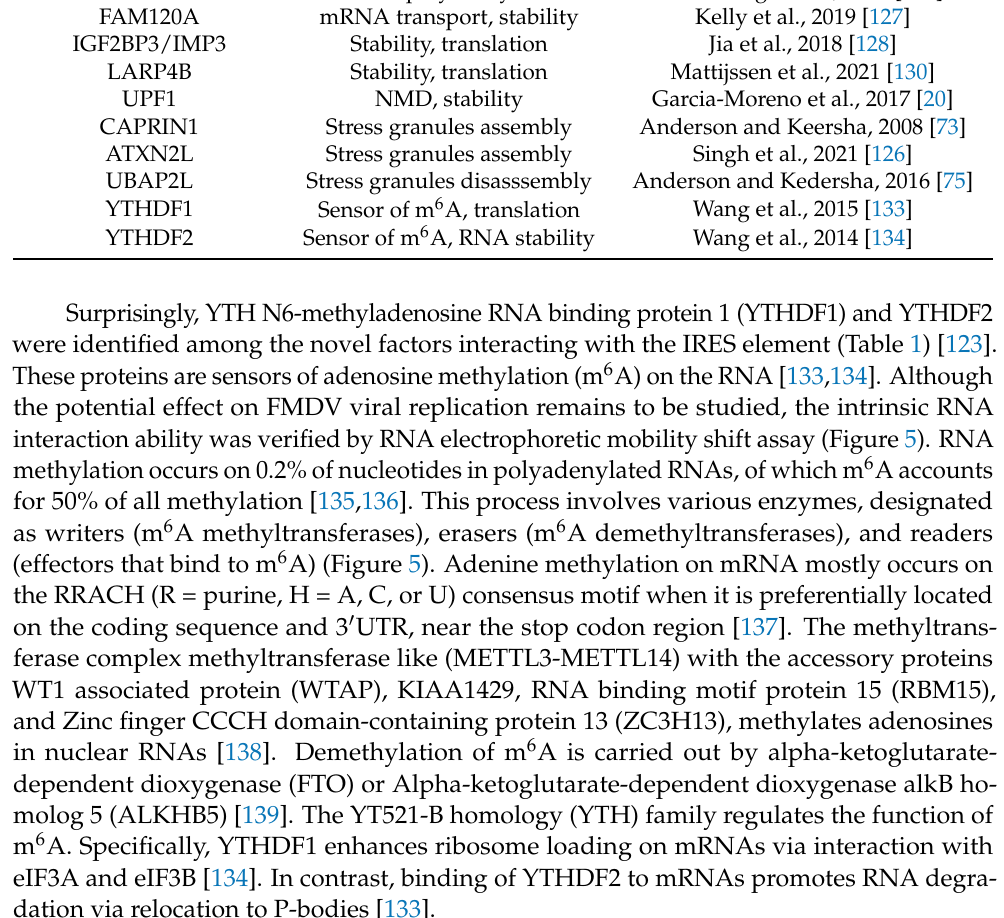
Kelly et al., 2019 [127]